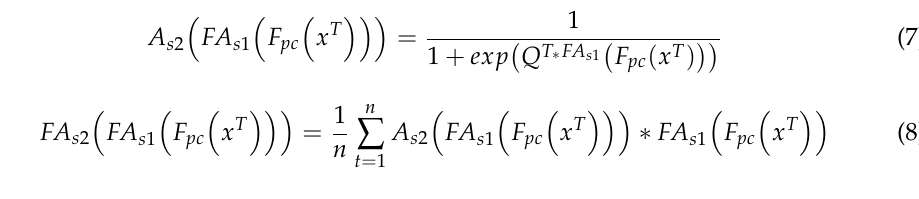
Figure 2. Attention block structure diagram. We note that F pc stereo space feature extraction module, A s 1 represents the attention weights of the facial expression images, and FA s 1 represents the weighted attention aggregated feature